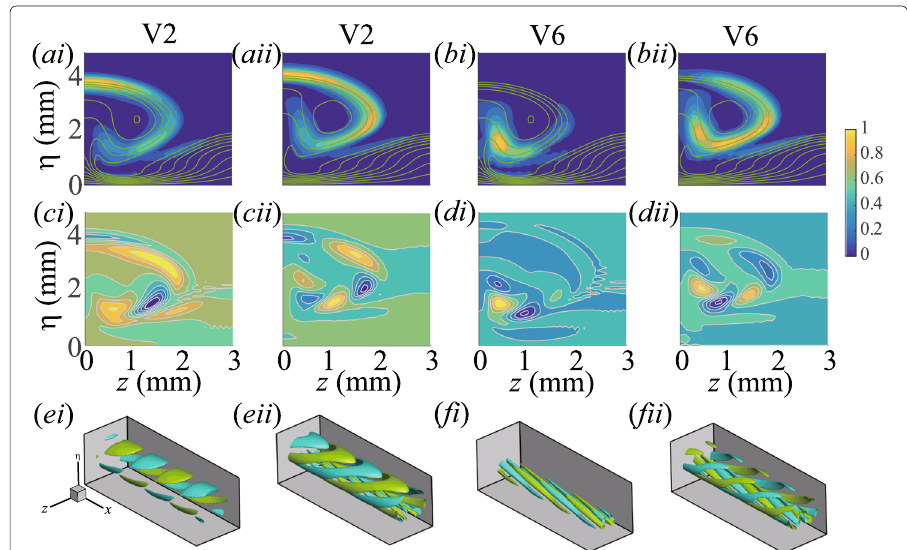
Fig. 5 The mode shapes of mode V2 ( a , c , e ) and mode V6 ( b , d , f ) in the upstream ( i , x = 286 mm) and downstream ( ii , x = 299 mm) from region R5. The first row denotes the (normalized) absolute part of the temperature eigenfunctions, the second row the real parts, the third row the spatial structures depicted by temperature isosurfaces with value of ± 50% of the maximum